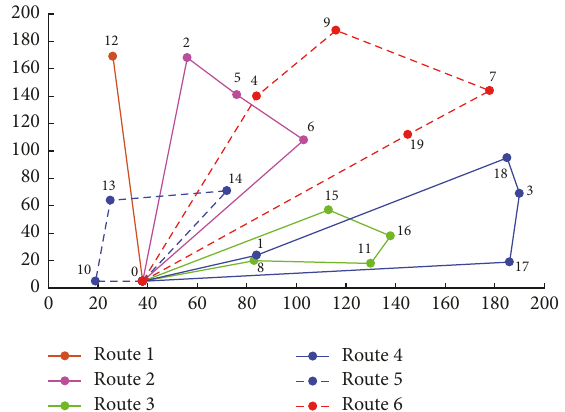
Figure 4: Plan of routes for Test Problem 2 after revealing the real values for the demands ( 𝜔 = 2